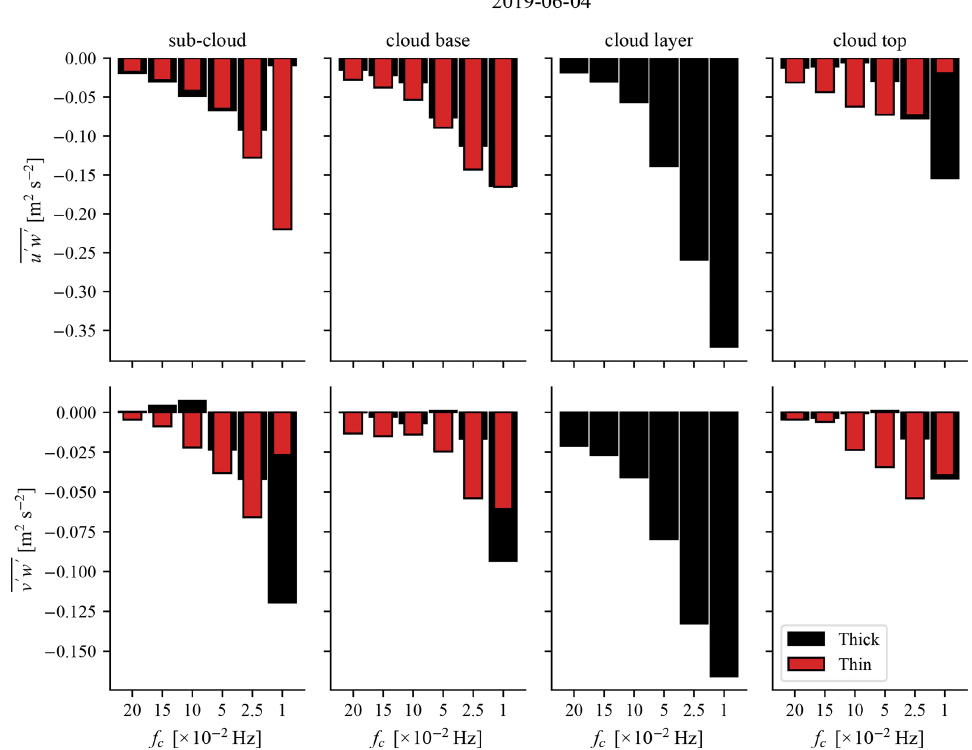
Figure 12. Scale contributions to the momentum flux u (cid:48) w (cid:48) (upper panels) and v (cid:48) w (cid:48) (lower panels) for different heights in the atmosphere. The bars in each panel represent the flux contribution, in which the left-most bar only includes small scales (frequencies exceeding 0.2Hz) and the right-most bar includes all scales that are represented in the measurements limited to 7km (with a cut-off frequency of 0.01Hz, excluding lower frequencies). Filter scales are 0.20, 0.15, 0.10, 0.05, 0.025, and 0.001Hz that, when assuming a cruising speed of 70ms − 1 , correspond to length scales of 350, 467, 700, 1400, 2800, and 7000m, respectively. The black bars represent the western leg with thicker clouds, the red bars represent the eastern leg with thinner